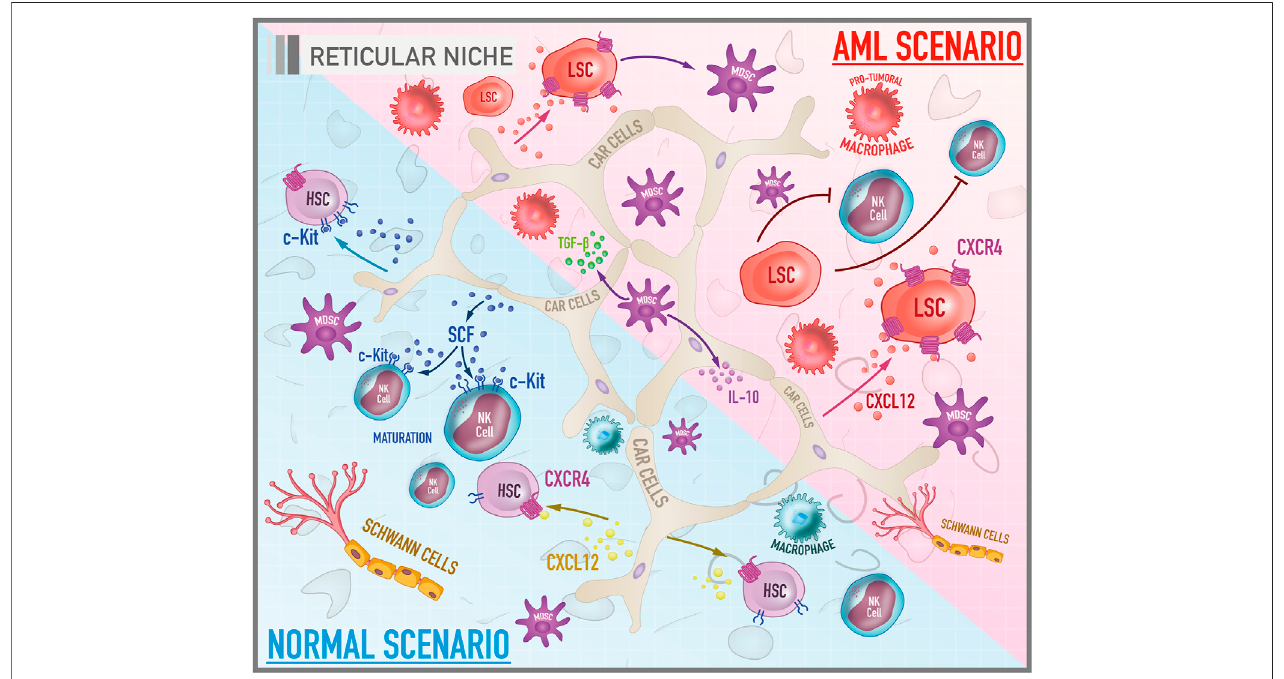
FIGURE 3 | Cellular and molecular components of bone marrow reticular niche in both healthy and leukemic scenarios. The illustration shows the reticular niche which is characterized by being a transitional niche between the endosteal and the vascular ones, responsible for the survival, homing and maintenance of HSCs and other hematopoietic progenitors in a proliferative, but undifferentiated pro fi le. Under physiological conditions, the most important pathways are CXCL-12/CXCR-4 and SCF/c-Kit. In the AML scenario, the CXCL-12/CXCR-4 signaling plays a role in the traf fi cking and in fi ltration of leukemic cells into the protective niches of the bone